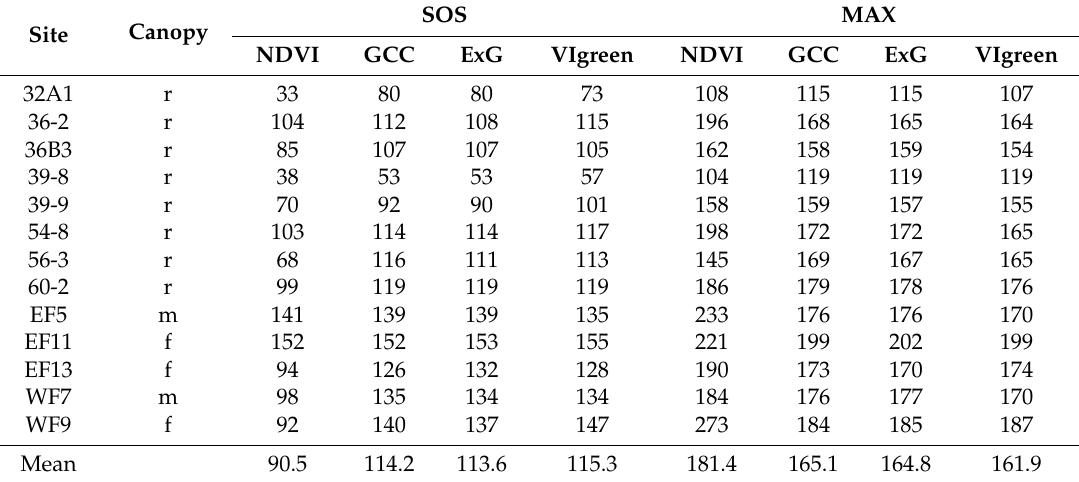
Table 2. Camera data indices (GCC, ExG, VIgreen) and MODIS NDVI derived estimates of start of season (SOS) and max of season (MAX) day-of-year. The canopy indicates whether the site was forested (f), rangeland (r) or mixed canopy (m). Idaho sites (32A1 to 60-2) are year 2015 data, Bitterroot sites (EF5 to WF9) are year